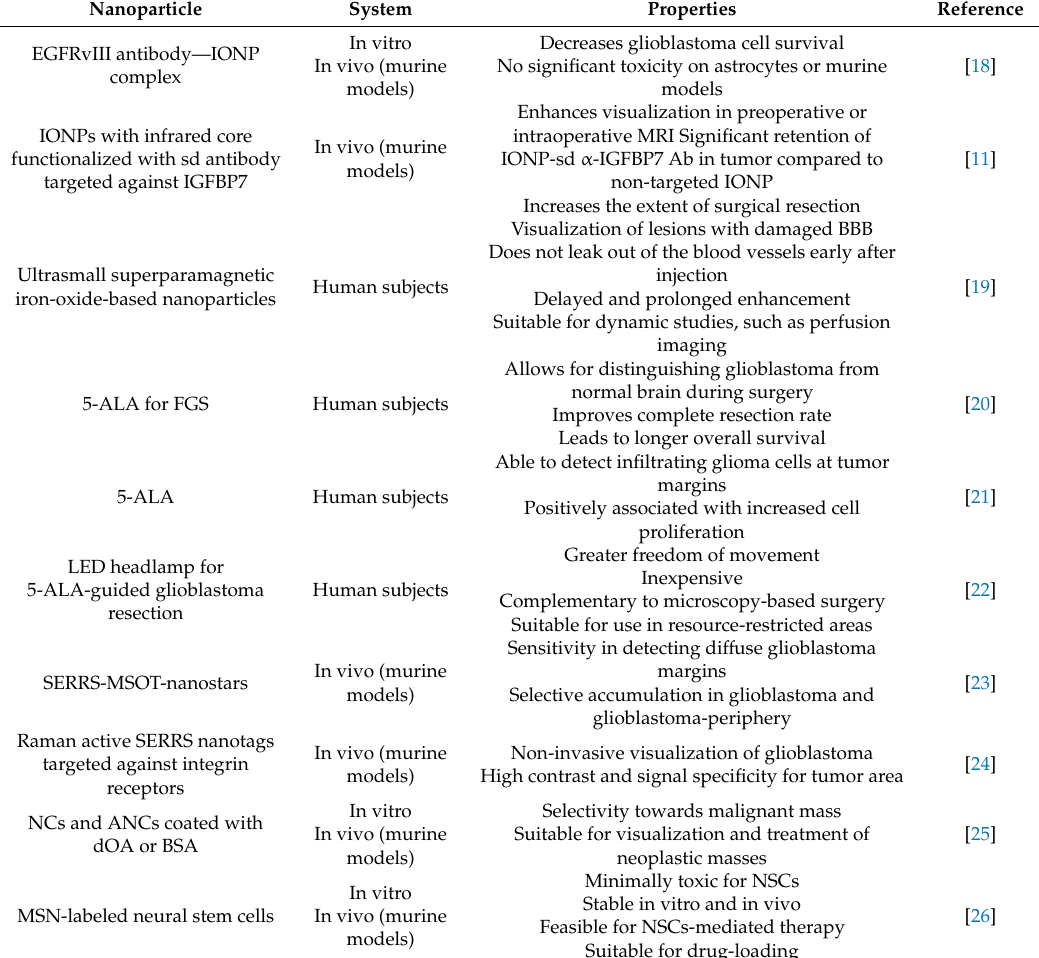
Table 1. Nanoparticles currently tested for glioblastoma